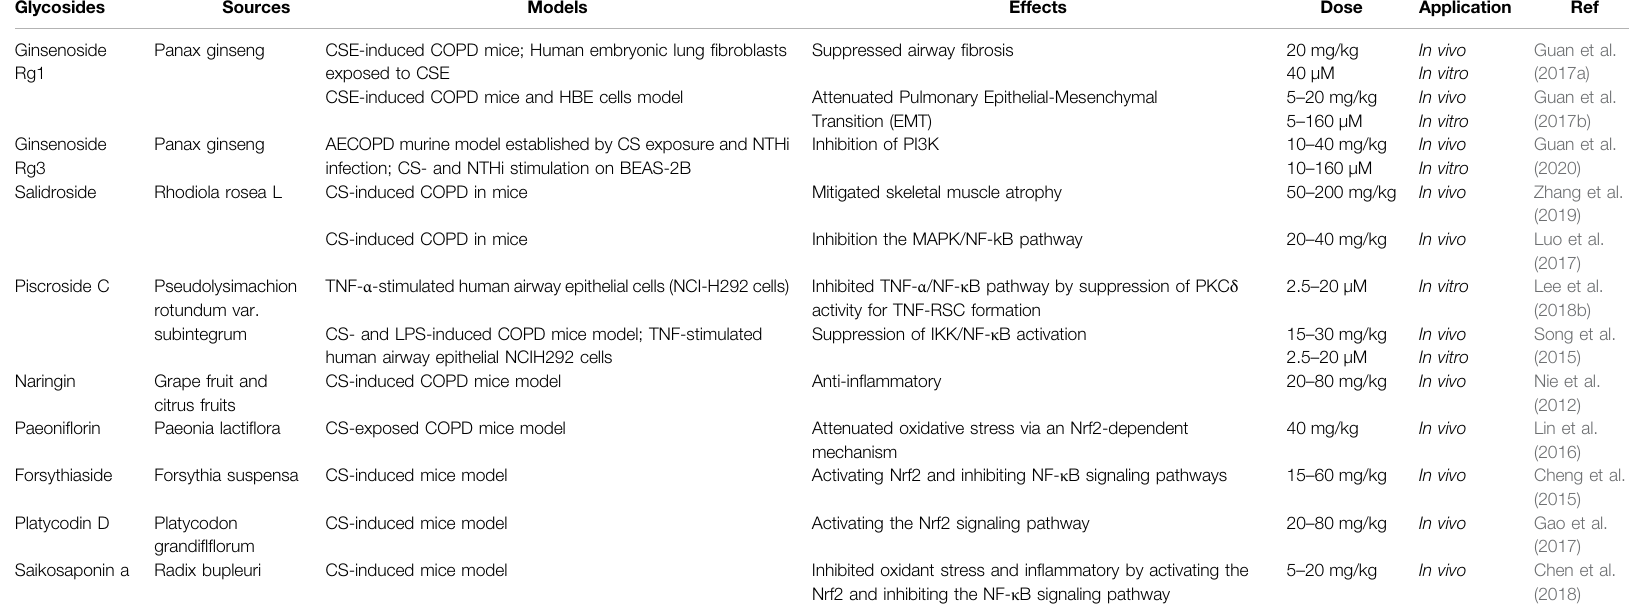
TABLE 4 | The effects of glycosides on